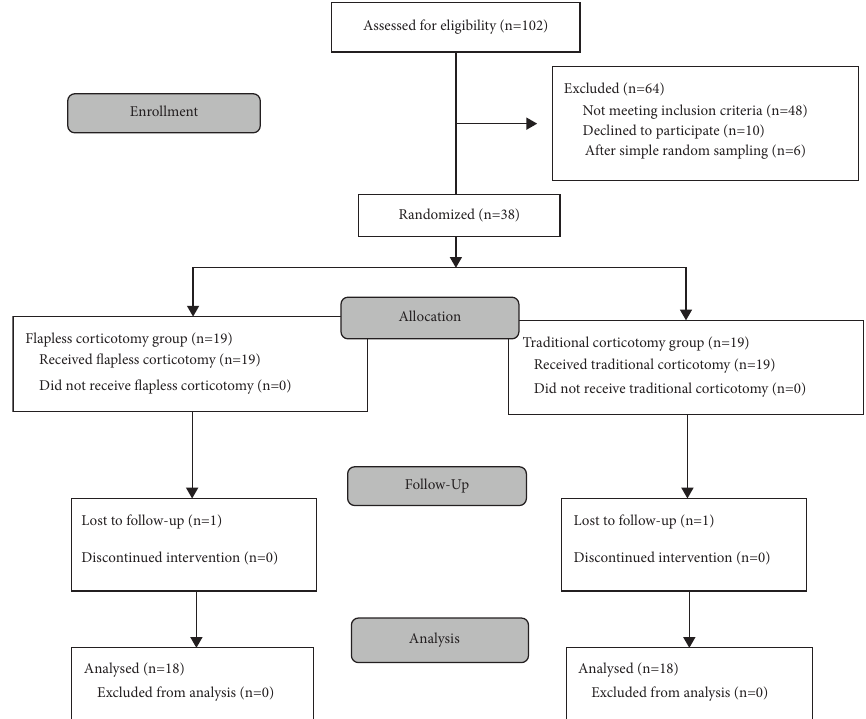
Figure 1: CONSORT (Consolidated Standards of Reporting Trials) participants’ flow diagram.